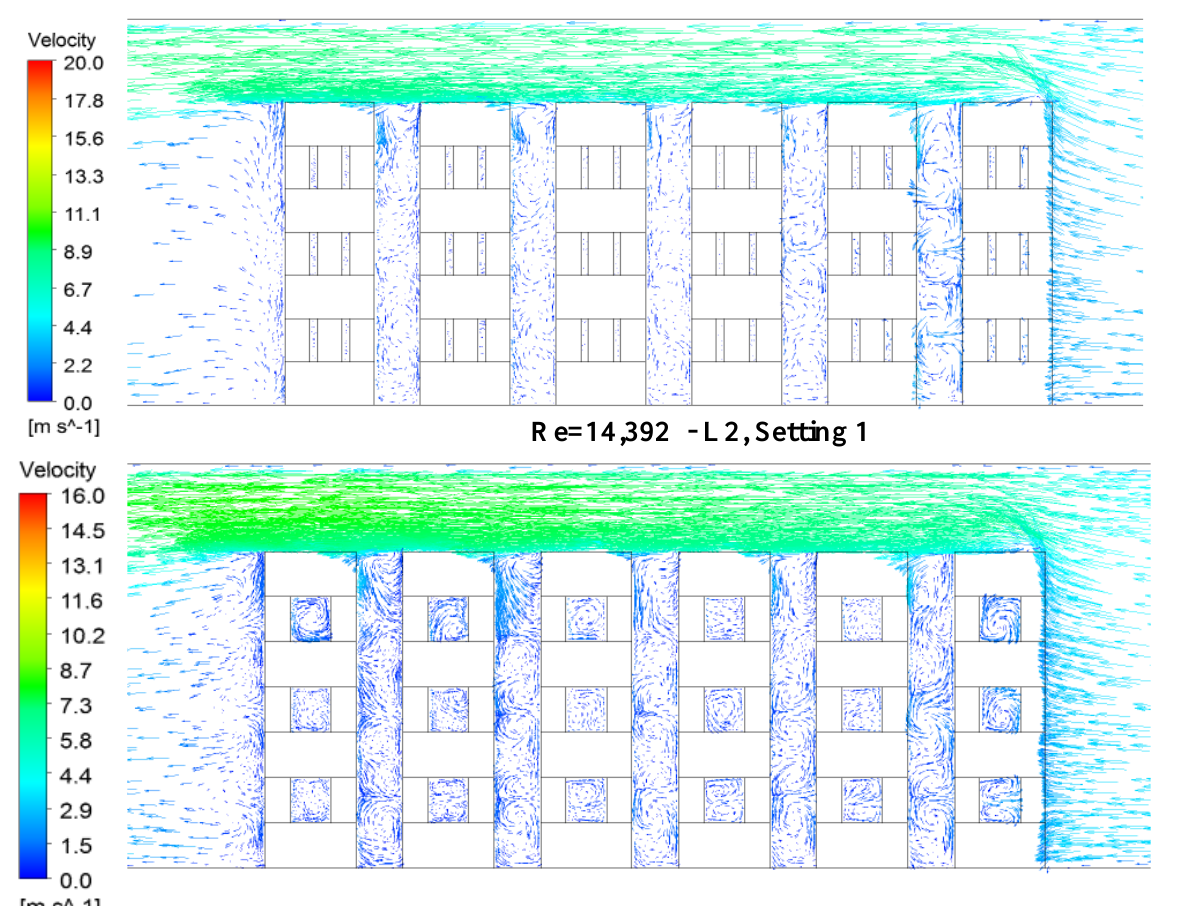
Figure 14. Velocity vectors for the plan (L2) pass through longitudinal bricks in the first column.